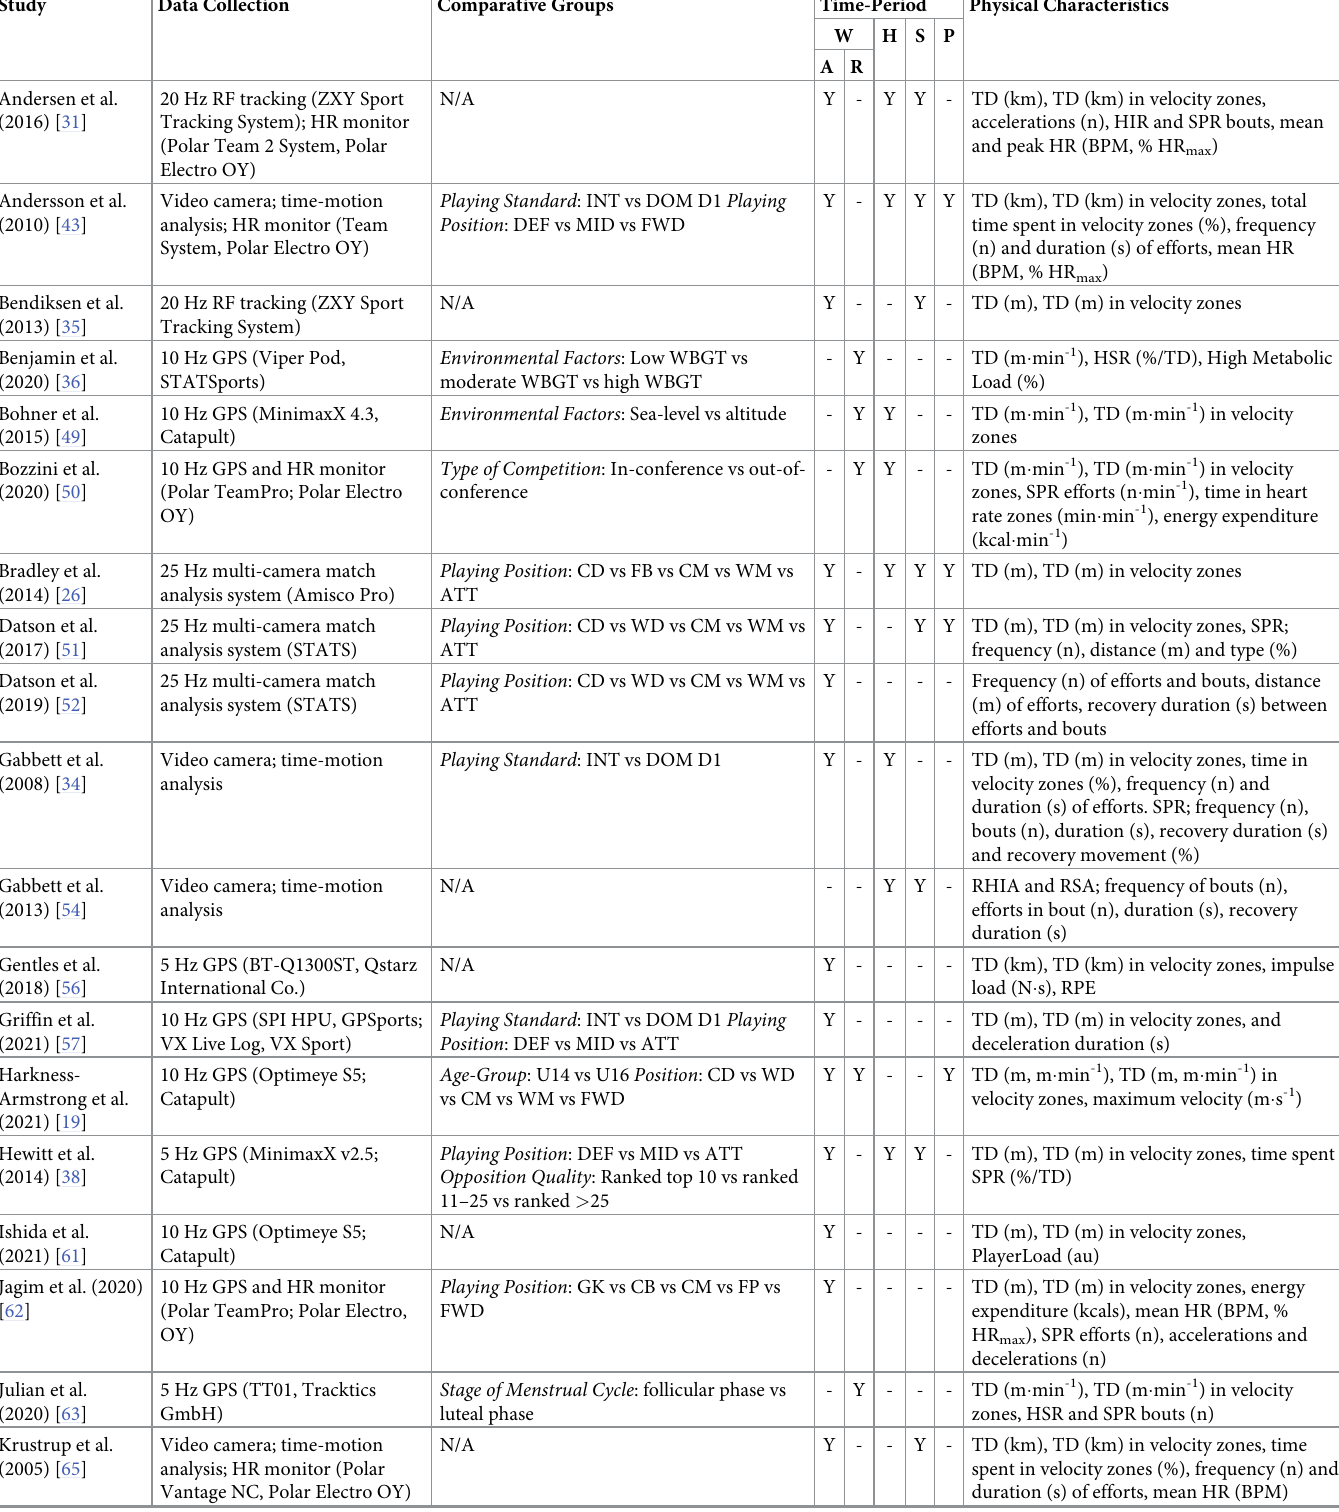
Table 4. Methods used to quantify physical characteristics of women’s soccer